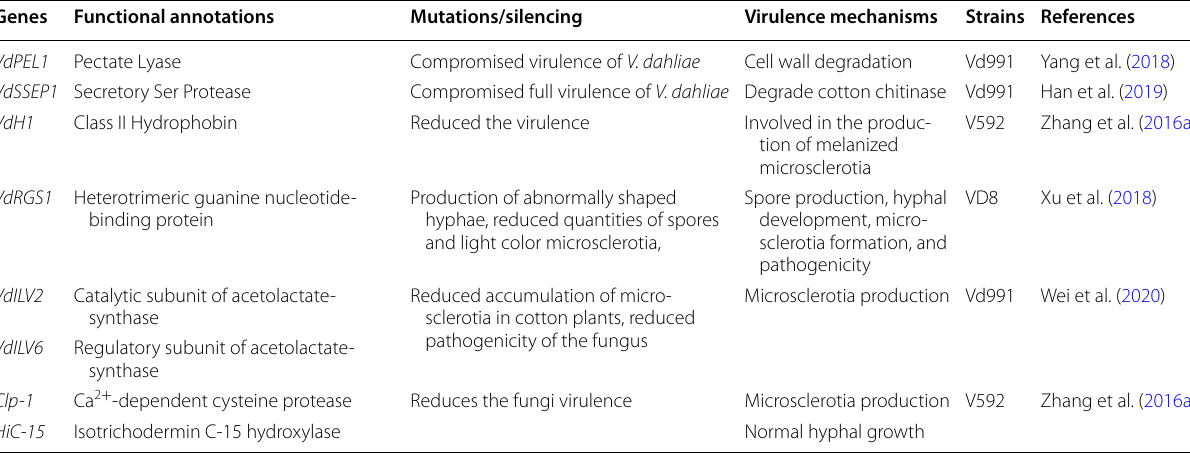
Table 2 Newly identified V. dahliae genes playing a role in the fungi virulence and pathogenicity